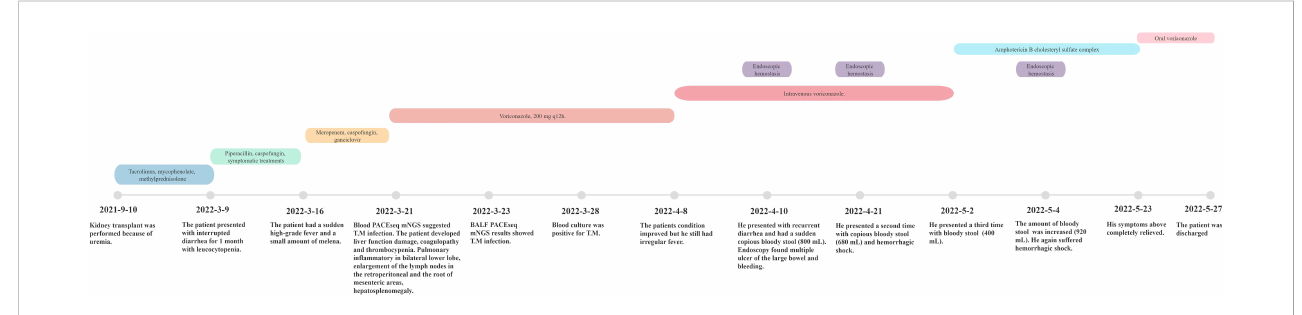
FIGURE 3 Important clinical information of the recipient and treatment timeline after renal transplantation.